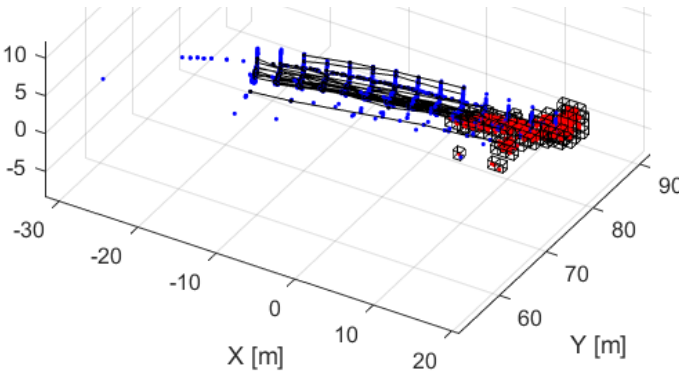
Figure 7. Illustration of the cube trajectory (CT) algorithm: the initial reconstruction (red dots) is calculated from the data (blue dots), then this reconstruction is decimated into cubes, and then the trajectories (black lines) of all cubes are determined based on the points in the cubes.